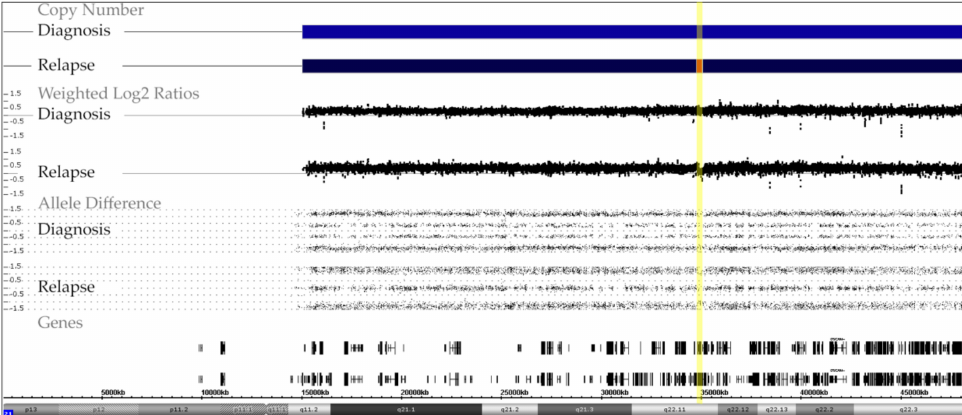
Figure A2. Chromosome 21 array patterns of a patient with a low hyperdiploid BCR-ABL1 -positive ALL, who had a trisomy 21 at diagnosis and a tetrasomy 21 at relapse. The karyotype at diagnosis was 51,XY,+X,+2,+4,t(9;22)(q34;q11),+21,+der(22)t(9;22) and the array one 51,XY,+X,CN-LOH(2)(p25.3 p11.2),dup(2)(q11.1q37.3) +4,del(9)(p24.3p21.2),del(9)(p21.3)x2/CDKN2A/B,del(9)(p21.1p13.1),t(9;22)(q34.12;q11.23)/BCR-ABL1,+der(22)t(9;22), +10,del(11)(q23.3),+21 the one at relapse was 53,XY,+X,+4,t(9;22)(q34;q11),+?10,+21,+21,+2mar and the array one 53,XY,+X,+Y,+4,dup(5)(q32q35.3),t(9;22)/BCR-ABL1,+10,dup(16)(p12.3q24.3),+21,+21. The mosaic pattern at relapse results from the fact that this sample contained only 40% blasts. As indicated by the yellow line, array analyses also uncovered a deletion in the relapse sample that removed nine genes of one of the four alleles: arr[GRCh37] 21q22.11(34756537_35032678)x2; 276 kb; IFNGR2, TMEM50B, DNAJC28, GART, SON, MIR6501, DONSON, CRYZL1, ITSN1